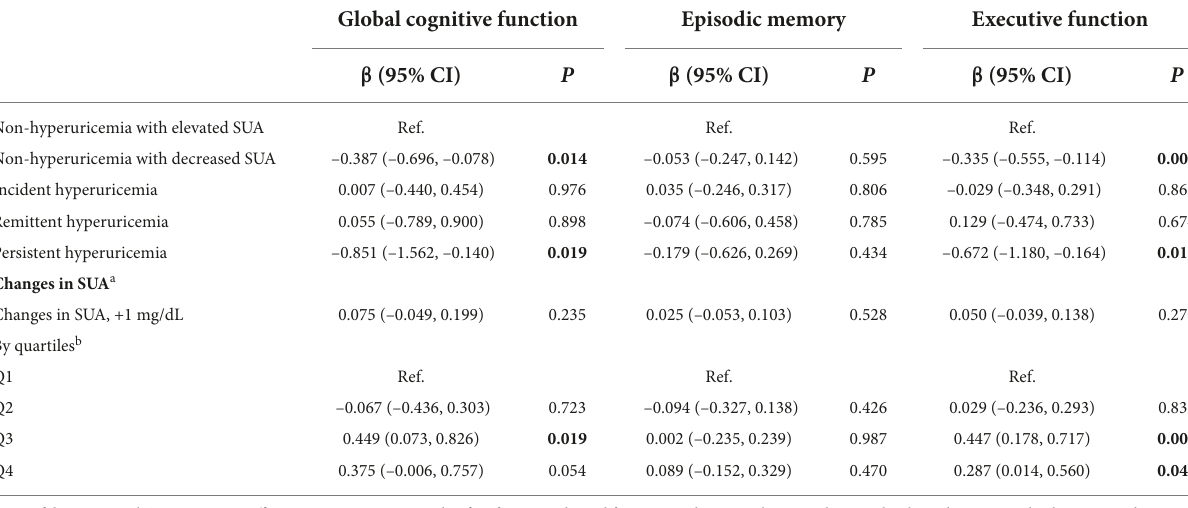
TABLE 4 Associations between changes in SUA and 3-year cognitive changes.